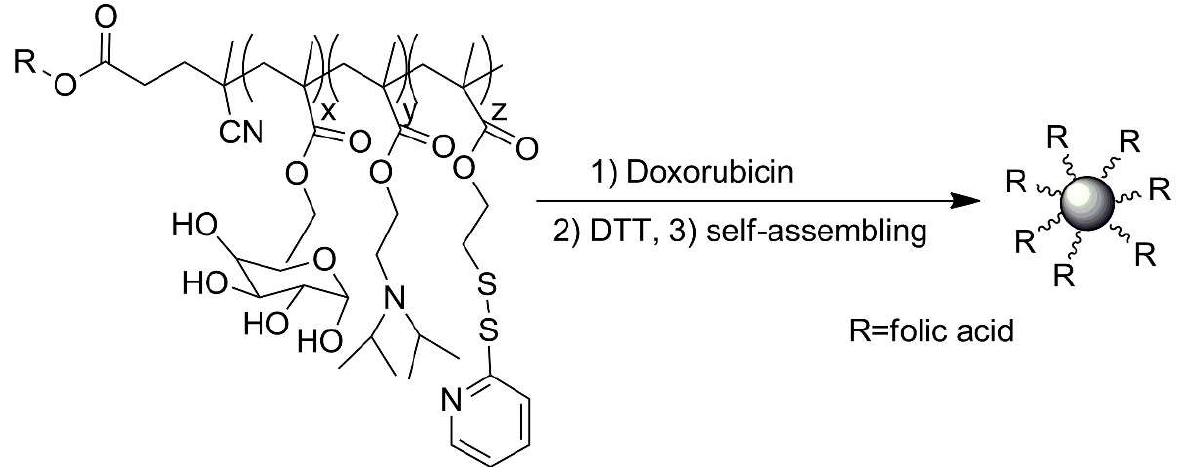
Scheme 16. Schematic illustration of formation of nanoparticles loaded with doxorubicin by self-assembly of FA-PMgDP copolymer. Explanations are in text.